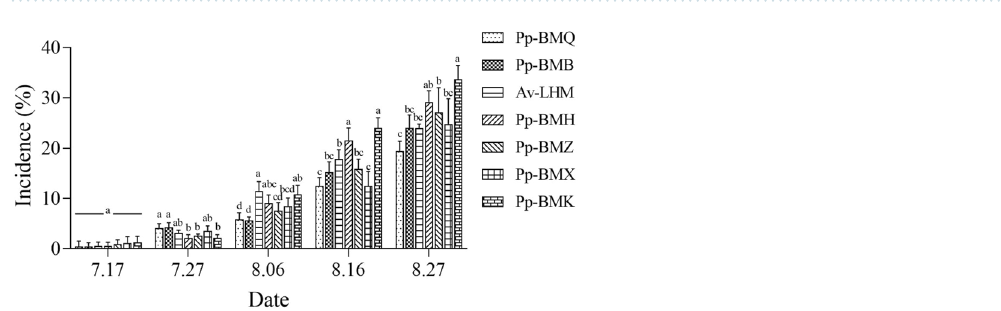
Figure 4. Phylogram generated for the Boeremia species from a Bayesian inference analysis based on the combined internal transcribed spacer region, the fragments of actin, β-tubulin and translation elongation factor-1 alpha genes. The tree was rooted to Phoma herbarum (strain: CBS 615.75).